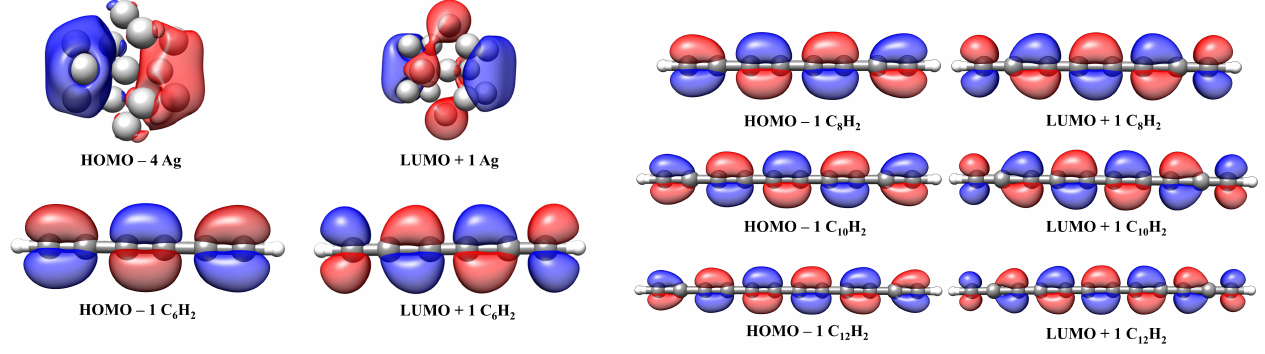
Figure 10. Electronic transitions of Ag NPs and C 2 n –H 2 at the TD-M062X/6-311+G(d,p)/LANL2DZ